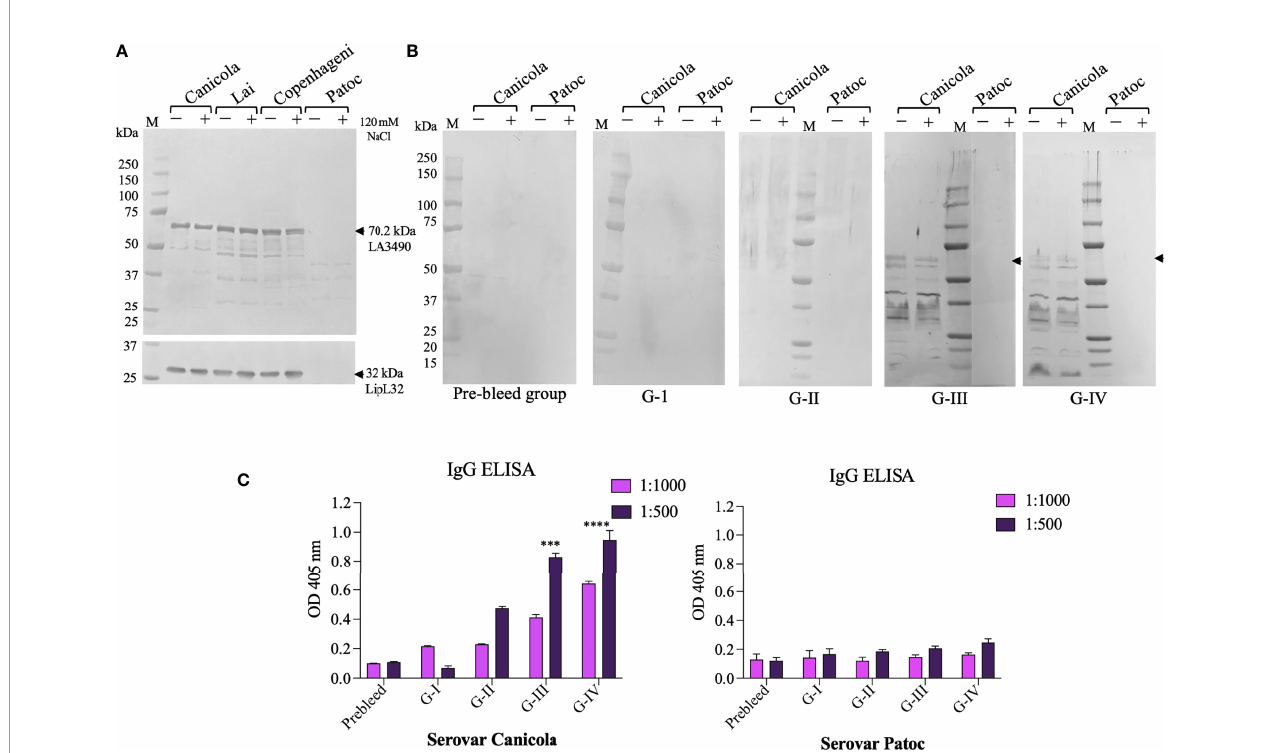
FIGURE 5 | In vitro and in vivo recognition of VM proteins in Leptospira cell free lysate by sera from immunized mouse groups. Pathogenic L. interrogans serovars Canicola, Lai, Copenhagni, and non-pathogenic L. bi fl exa serovar Patoc were grown in conditional EMJH medium which was induced with 120 mM NaCl for 4 h in log phase and unconditional EMJH medium and cells were harvested. Cell-free lysates were analyzed by 4-12% SDS-PAGE, then transferred to a nitrocellulose membrane for Western blot analysis. (A) The membrane was probed with polyclonal LA3490 antibodies (1:2,000 dilution) and LipL32 monoclonal antibody (1:10,000) which was served as loading control. (B) The other set of membrane were probed with pooled sera (1:100 dilution) collected before immunization (pre-bleed) and after challenge Group I (PBS+ adjuvant), Group II (t3490), Group III (VM Mix) and Group IV (VM Unlabeled. (A, B) Leptospira grown in EMJH medium without addition of NaCl, represented by minus ( – ), and Leptospira grown in EMJH medium to log phase, at which time 120 nM NaCl was added, represented by plus (+). Arrows indicate the expression of 70.29 kDa native VM proteins. (C) Anti- Leptospira immunoglobulins generated against with serovars Canicola after experimental infection of C3H/HeJ suspectable mice. Whole cell IgG ELISA were performed with pre-bleed and sera from immunized mice post-challenge. Serovar Patoc served as negative control. ***p < 0.001, ****p < 0.0001